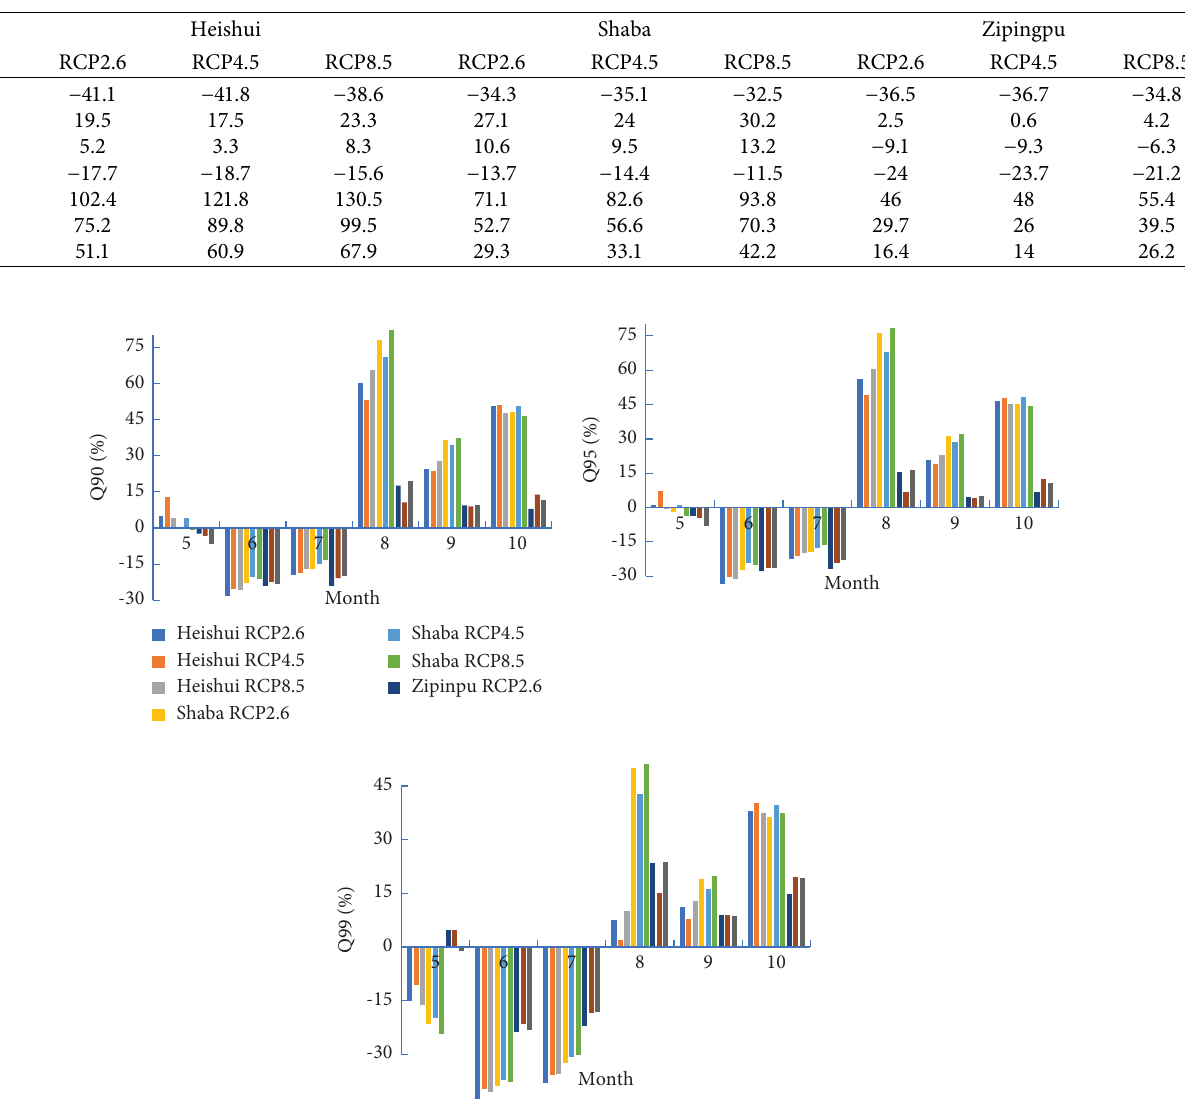
Figure 5: Variation of quantile runof from May to October in the upper reaches from 2021 to 2050